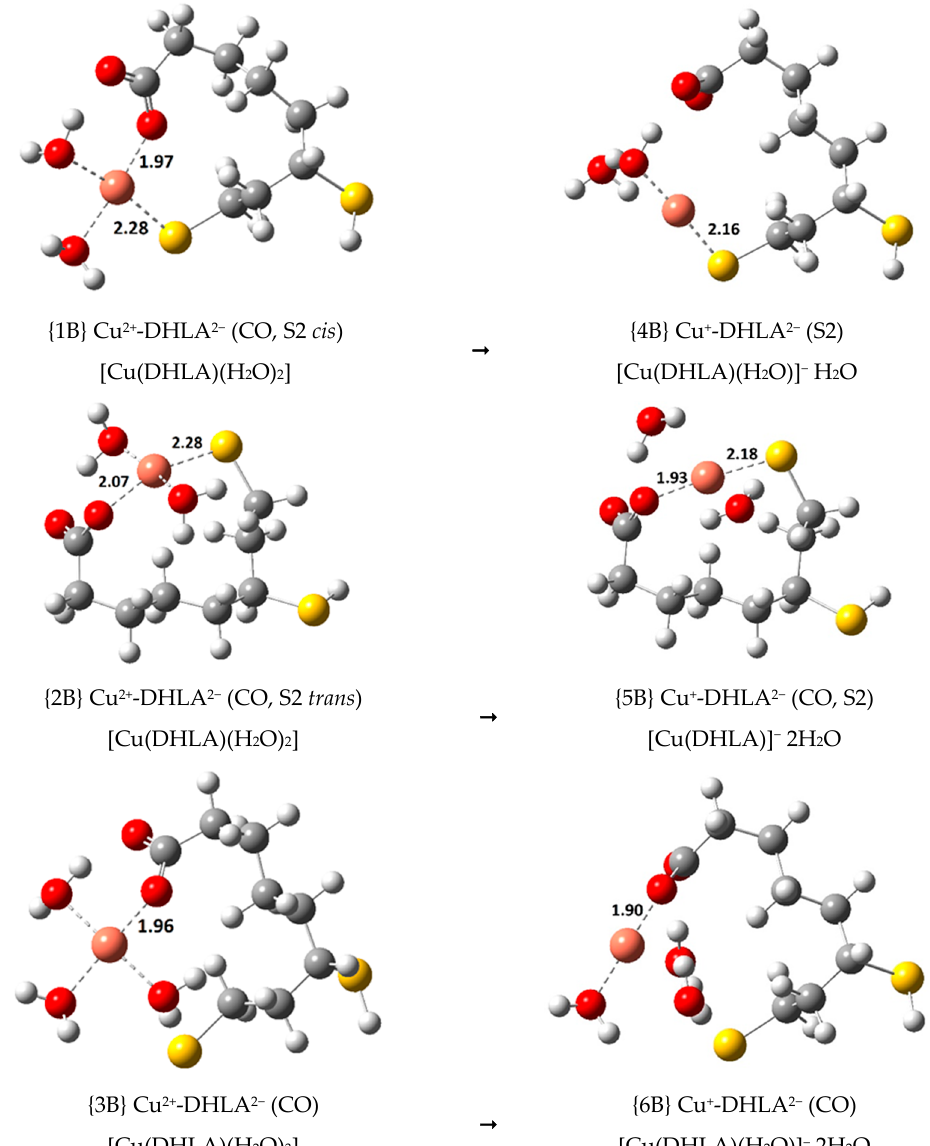
Figure 10. M06 optimized structures (bond distances in Å) of the three most stable Cu(II) complexes ({1B}, {2B}, {3B}), reported in Ref. 10 at the M06-2X level of theory, together with the optimized geometries of the corresponding Cu(I) complexes ({4B}, {5B}, {6B}). The most stable Cu(II)-LA - complex (reported as {1} in Reference 10; now labelled {9B}) was also